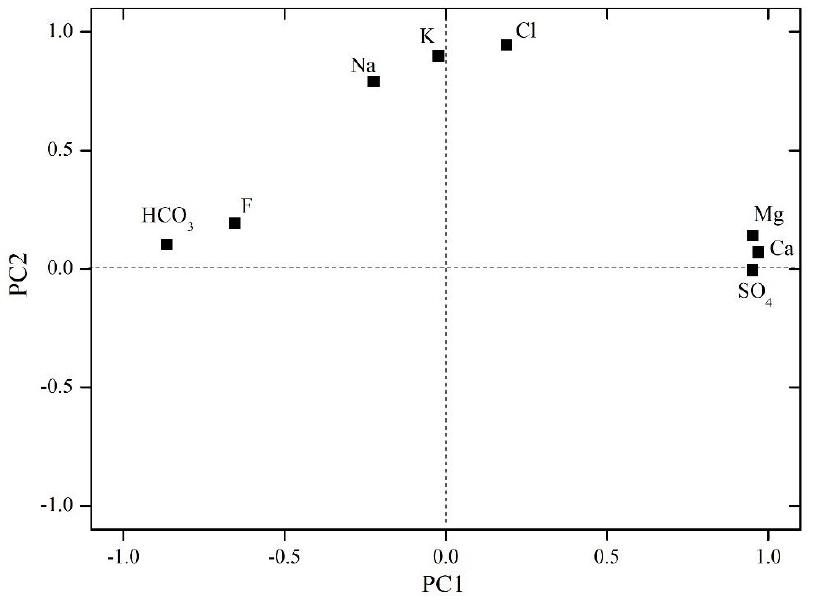
Figure 5. Distribution of ion load values on principal components.